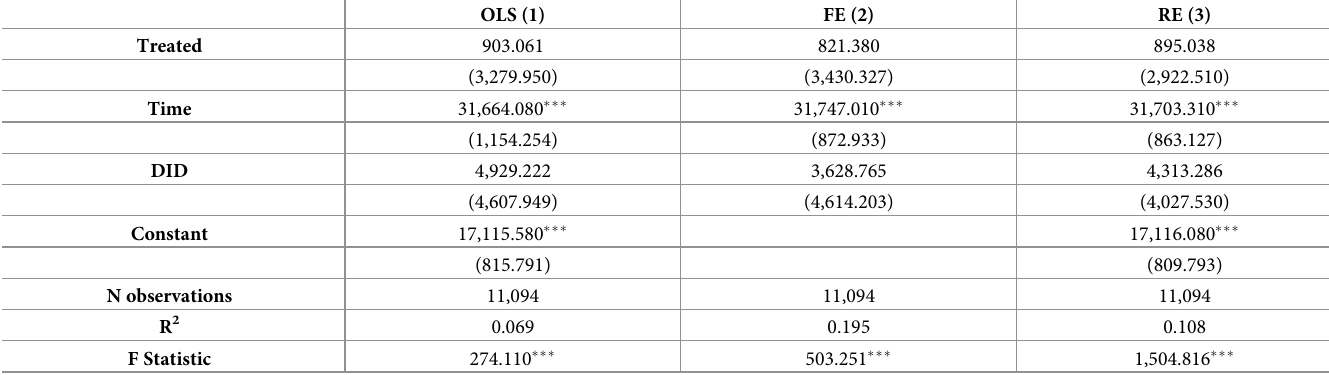
Table 10. Difference-in-differences with PSM weight agriculture GVA results: Pooling, fixed-effects, and random-effects .